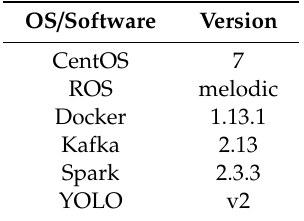
Table 3. Software-platform information.